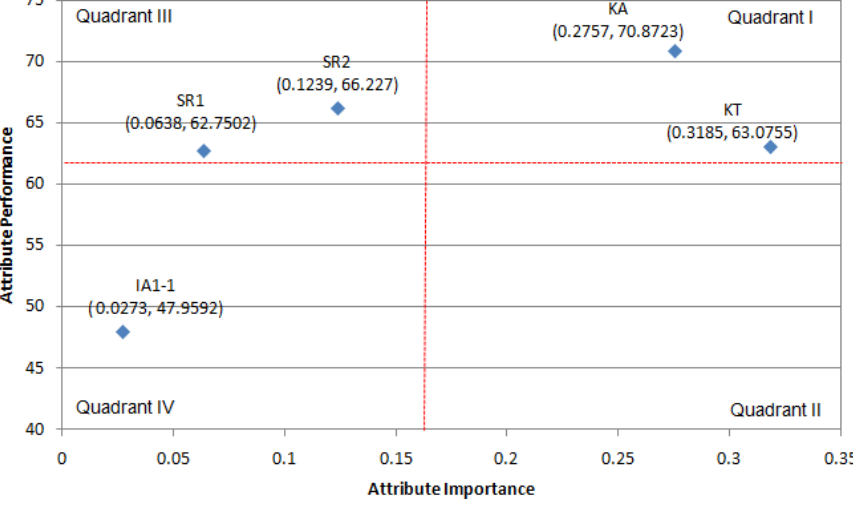
Figure 5. The IPMA map of the target OiP (indicator level).